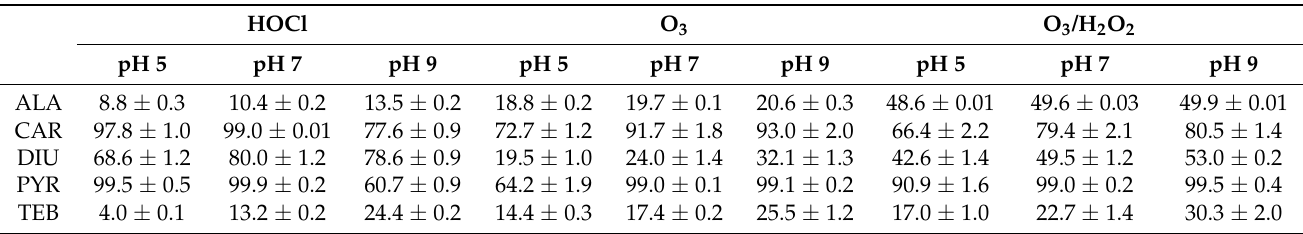
Table 3. The effects of pH on the removal efficiencies (%) of the selected pesticides by HOCl, O 3 and O 3 /H 2 O 2 processes (initial concentration of each pesticide = 2 µ M, reaction time = 0.5 h, temperature = 25 ◦ C).